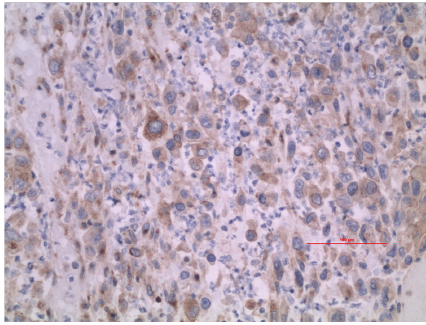
Figure 5: Malignant cells showing positive Immunohistochemistry for CD 99 (20x).